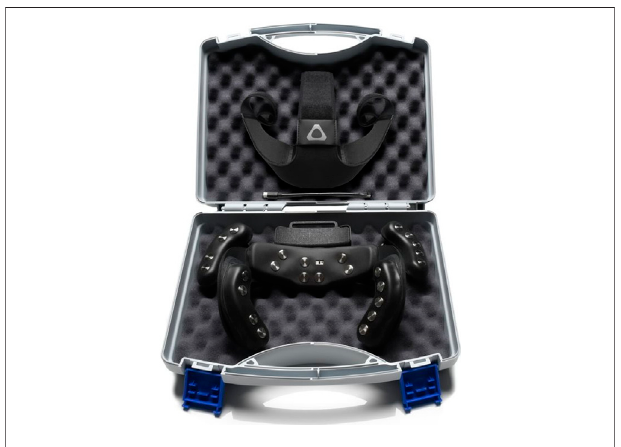
FIGURE 4 | EmteqPRO inserts are mounted onto two different headsets. (A) HTC Vive Pro headset. The same inserts are also compatible withtheHTCViveProEyemodel (B) PicoG24 kall-in-oneheadset.Thesame inserts are also compatible with the regular G2, and Neo 2 Eye